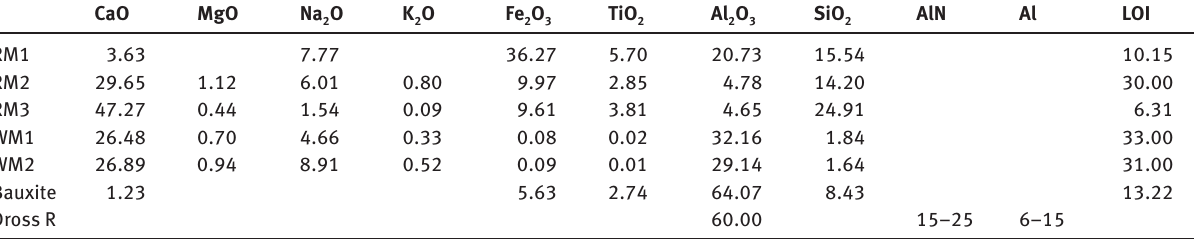
Table 1: Chemical Compositions of Various Materials containing Alumina